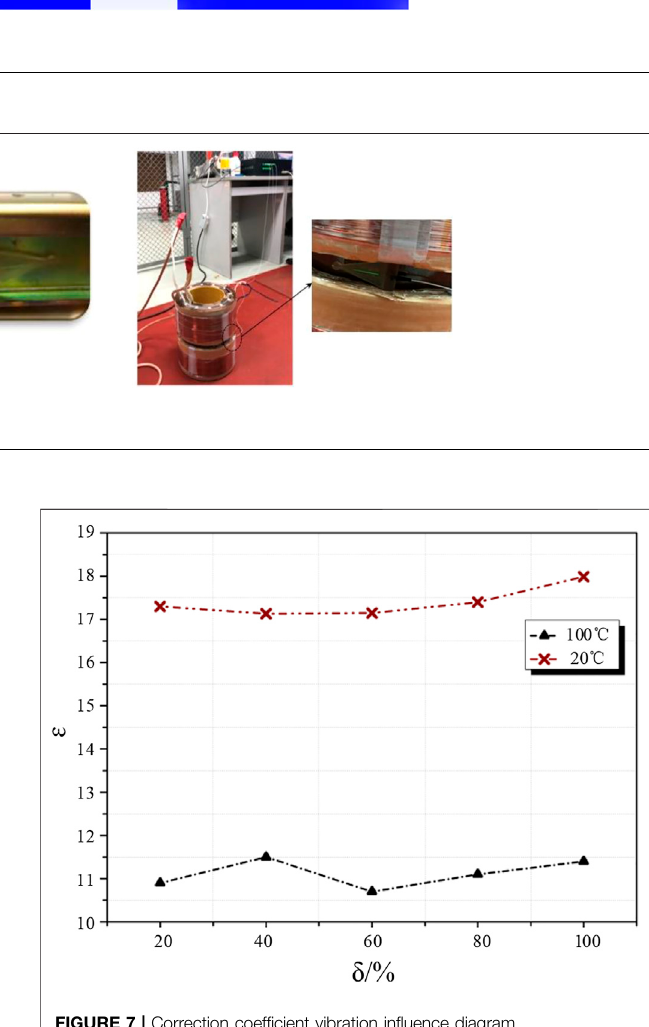
FIGURE 6 | DFB vibration experiment waveform. FIGURE 7 | Correction coef fi cient vibration in fl uence